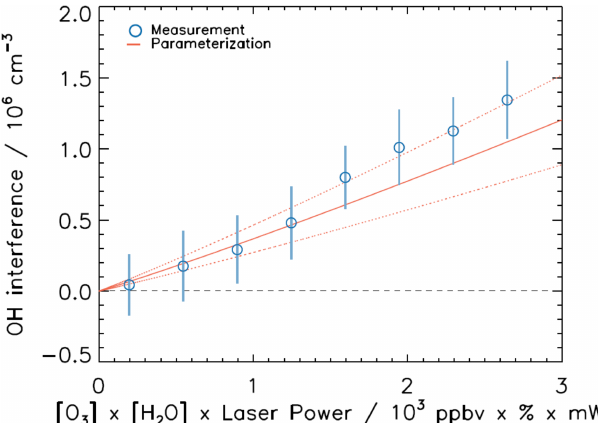
Figure 13. Averaged OH interference measured during all JULIAC periods (vertical bars are standard deviations of the bin averaged data) compared to a parameterization (Eq. 19 and Sect. 3.5.1) deter- mined in laboratory experiments. The red dotted lines represent the uncertainty of the parameterization. Each bin is averaged by more than 100 data